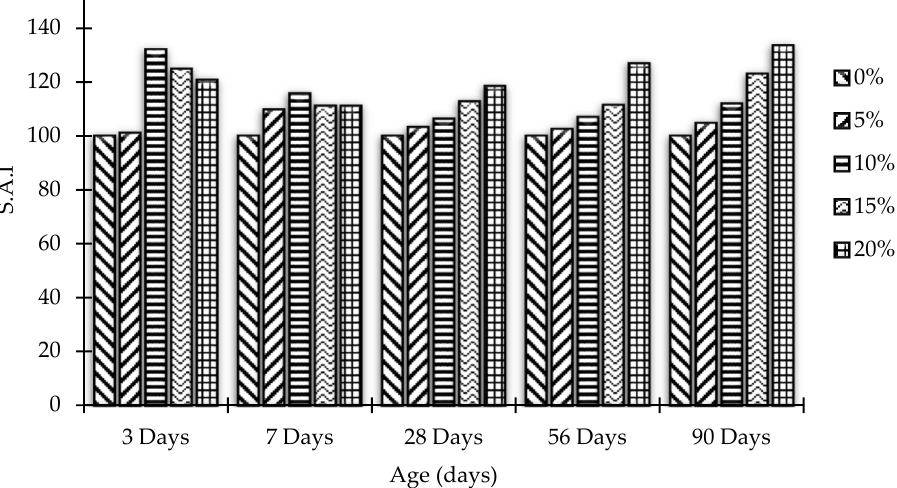
Figure 9. Effects of the curing age on compressive strength activity index (SAI) of all mixes.